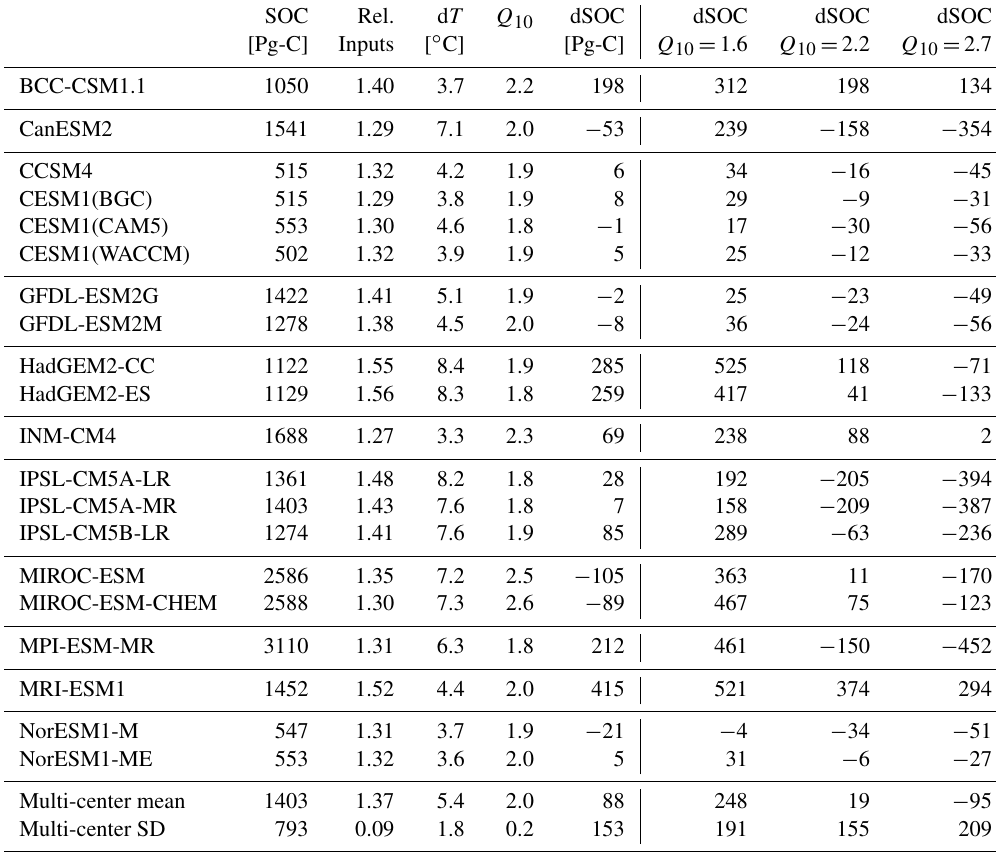
Table 2. Global model summary with multi-center mean and standard deviation for modern soil organic carbon (SOC) stocks (Pg-C), relative shift in soil inputs ( u f /u m ), absolute change in soil temperature (d T ) ( ◦ C), inferred mean of Q 10 as calculated by grid cell (see Eq. 5), change in soil organic carbon (dSOC) over the 21st century (Pg-C), and change in soil organic carbon with rescaled Q 10 values (1.6, 2.2, and